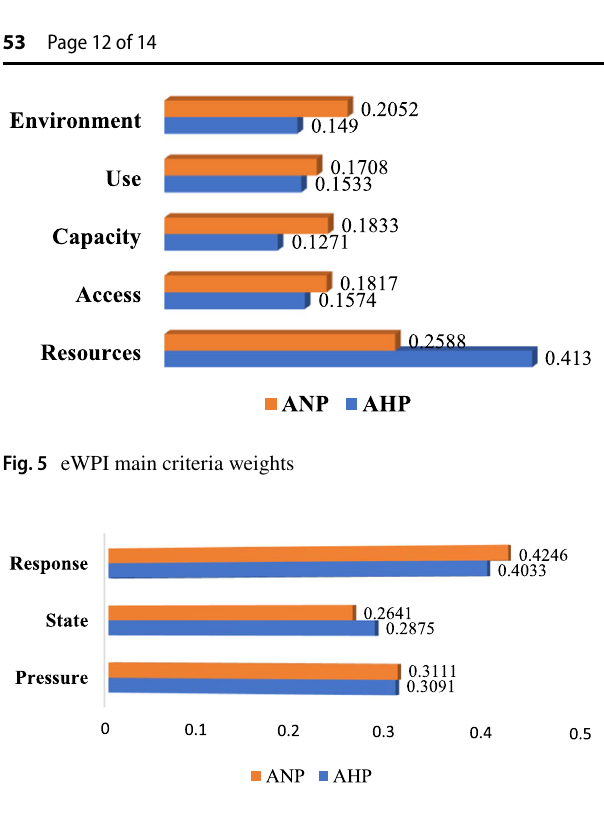
Fig. 6 The weight of Pressure, State, and Response in AHP and ANP Table 6 eWPI components weighted by AHP (Watershed Scale) Criteria